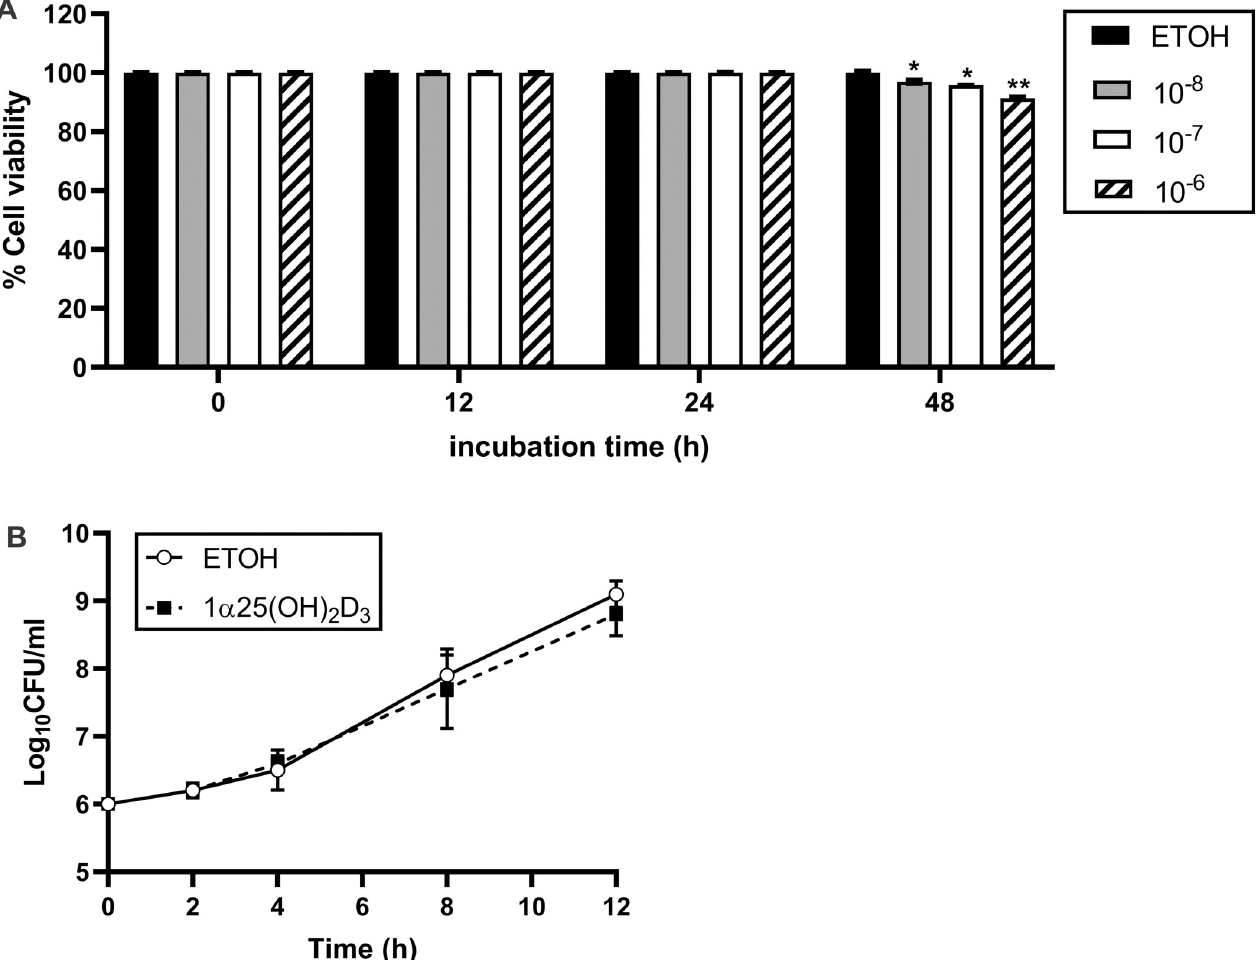
Fig 1. Effect of 1 α ,25(OH) 2 D 3 on the survival of A549 cells and B . pseudomallei H777. (A) A549 cells were incubated with 1 α ,25(OH) 2 D 3 (10 − 8 M, 10 − 7 M, 10 − 6 M) for 0, 12, 24, 48 h. Cytotoxicity was determined using the LDH assay. (B) B . pseudomallei H777 was incubated with 1 α ,25(OH) 2 D 3 (10 − 6 M) for 0, 2, 4, 8 and 12 h. Bacterial viability was determined using the drop plate technique. The results are shown as mean ± SD from three independent experiments each carried out in triplicate. � P < 0.05 and �� P <